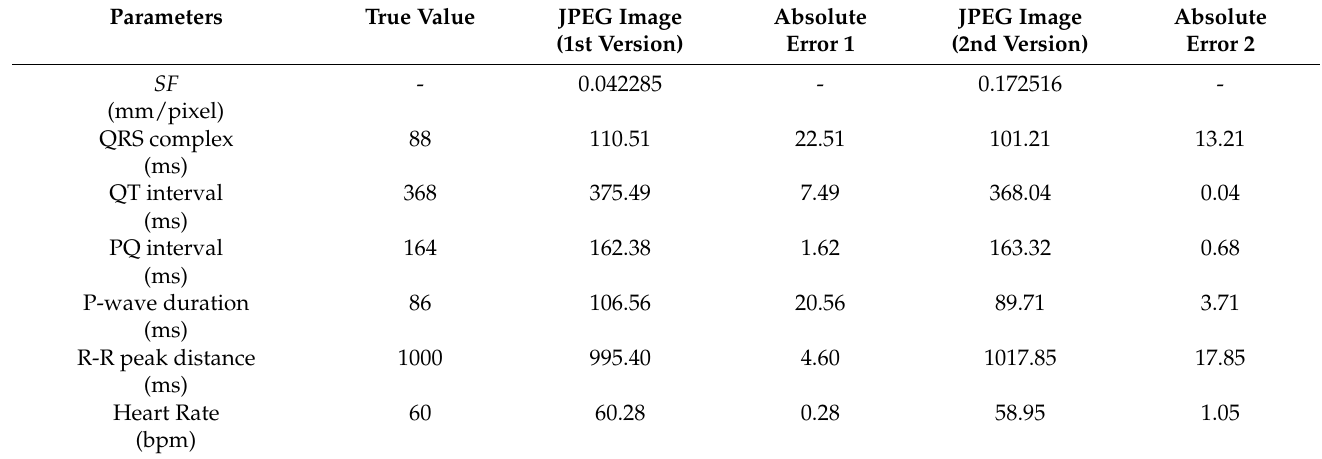
Table 4. The comparison of the scale factor and the time parameters obtained by cropping two versions of the same ECG image (normal sinus rhythm, 60 bpm). The second column shows the values of the ProSim simulator (Ground Truth). The fourth column reports the absolute errors between the first image and the true value, while the sixth column shows the absolute errors between the second image and the true